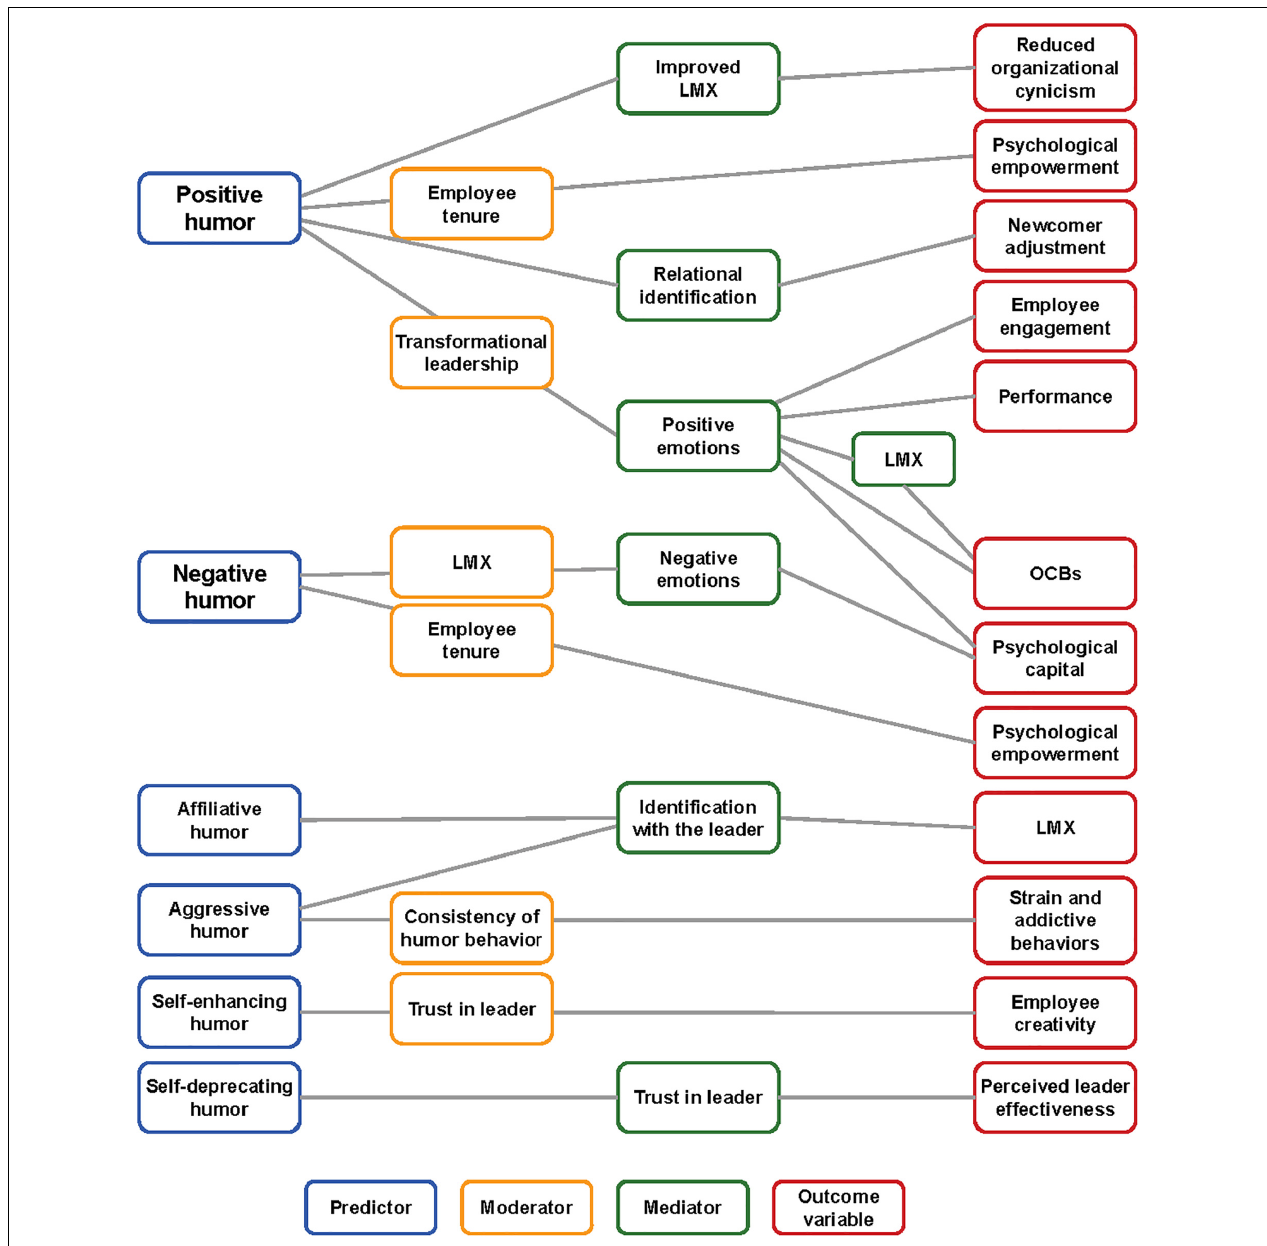
FIGURE 3 | An illustrated summary of the outcome variables of the studies that investigated different humor